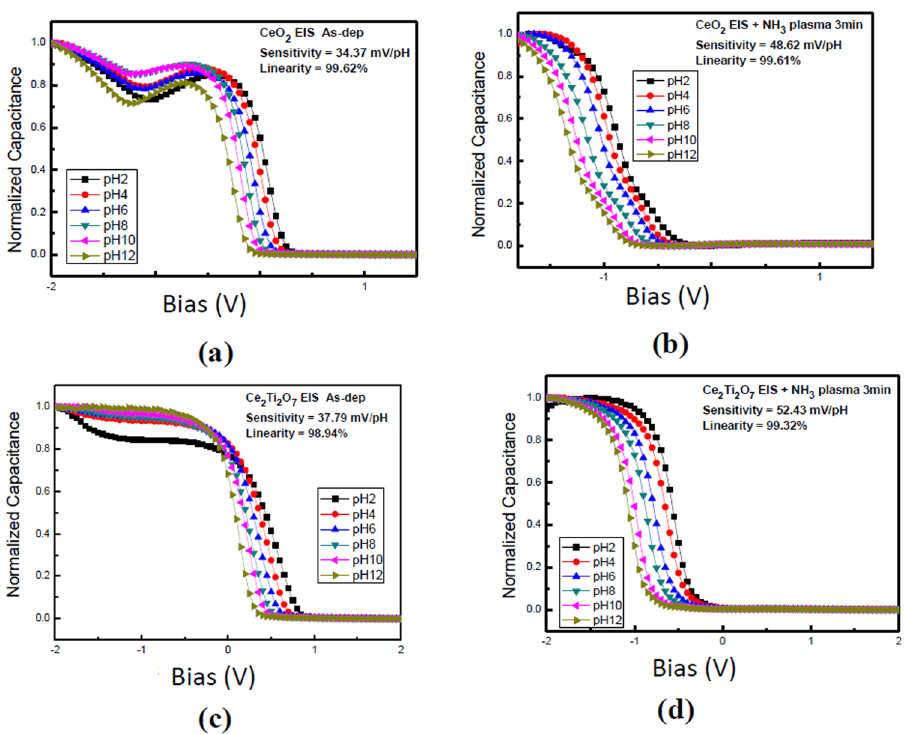
Figure 6. The normalized C-V curve of the CeO 2 sample ( a ) without NH 3 plasma treatment and ( b ) with NH 3 plasma treatment for 3 min. The normalized C-V curve of the Ce 2 Ti 2 O 7 sample ( c ) without and ( d ) with NH 3 plasma treatment for 3